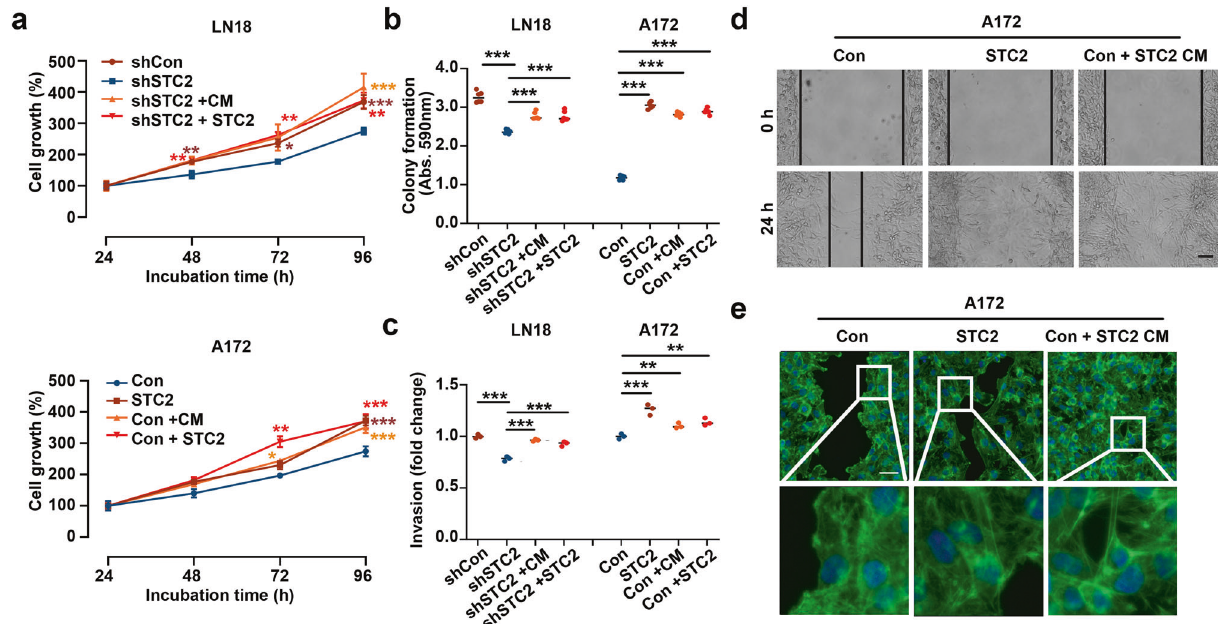
Fig. 3 Secreted STC2 induces invasive phenotypes of neighboring GBM cells. a Cell growth rates after treatment of recombinant STC2 (100 ng/mL) or STC2-containing CM were determined using MTT assay. Means ± SD; n = 12 biological replicates. Student ’ s two tailed t-test, * p < 0.05, ** p < 0.01, *** p < 0.001. Signi fi cance was analyzed against shSTC2 in LN18, Con in A172. b , c ) Colony formation ( b ) and in vitro invasion ( c ) were determined after treatment of recombinant STC2 (100 ng/mL) or STC2-containing CM. Absorbance at 590 nm was measured after dissolving with 10% acetic acid. Means ± SD; n = 3 biological replicates; One-way ANOVA, ** p < 0.01, *** p < 0.001. d In vitro migration was determined after treatment of recombinant STC2 (100 ng/mL) or STC2-containing CM. Scale bar = 100 µm. e Migrating cells were visualized using fl uorescent phalloidin (green) and DAPI (blue) staining. Scale bar = 50